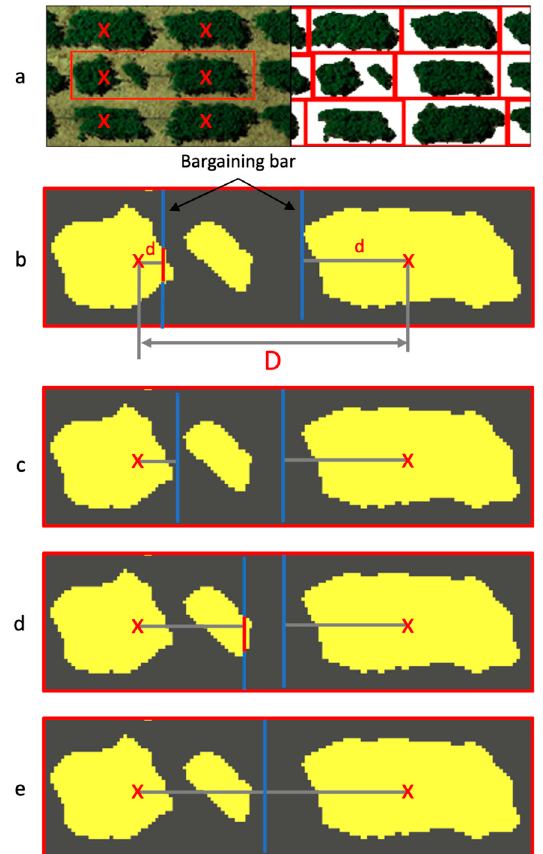
Figure 4. Boundary bargaining between adjacent plots. The bargaining between two plots starts at their center points in either column or row directions ( a , left). The final boundaries ( a , right) are determined by the movement of bargaining bars. A bargaining bar moves away from its center if it has more power than its opponent. The power of a bargaining bar is defined by its proportion of pixels of interest (POI, red area on the bar itself) over the total pixels (red + blue on the bar) adjusted by a penalty. The penalty is a bargaining bar’s distance to its plot center (lower case red d) divided by the distance between the centers of the two plots (upper case red D), multiplied by a weight (default of 0.2). The right plot has more power than the left plot and reaches its left edge first ( b ). When left and right plots do not have POI intersecting their bargaining bars, both bars move forward ( c ). After the left plot finds its separated POI, it gains power and moves to the right edge ( d ). At the end of the bargaining process, both plots run out of POI and the bars move simultaneously to complete the connection and form the boundary ( e